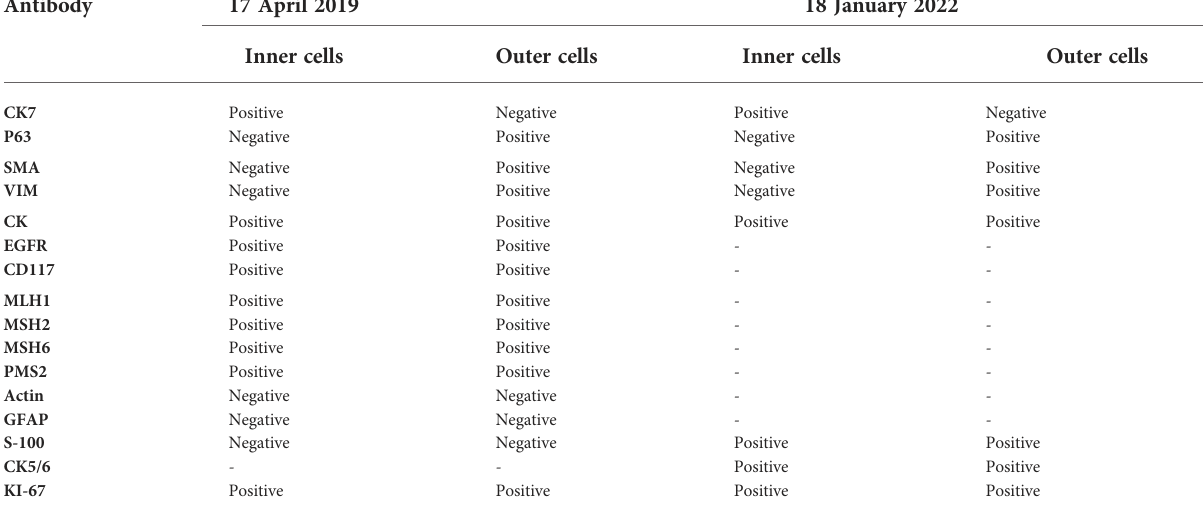
TABLE 1 Immunohistochemistry fi ndings from 17 April 2019 and 18 January 2022.